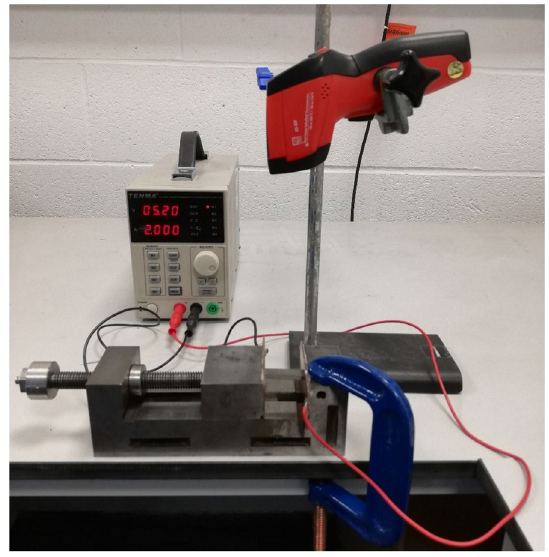
Fig. 3 Experimental set-up for electrical conductivity measurements of composite laminates